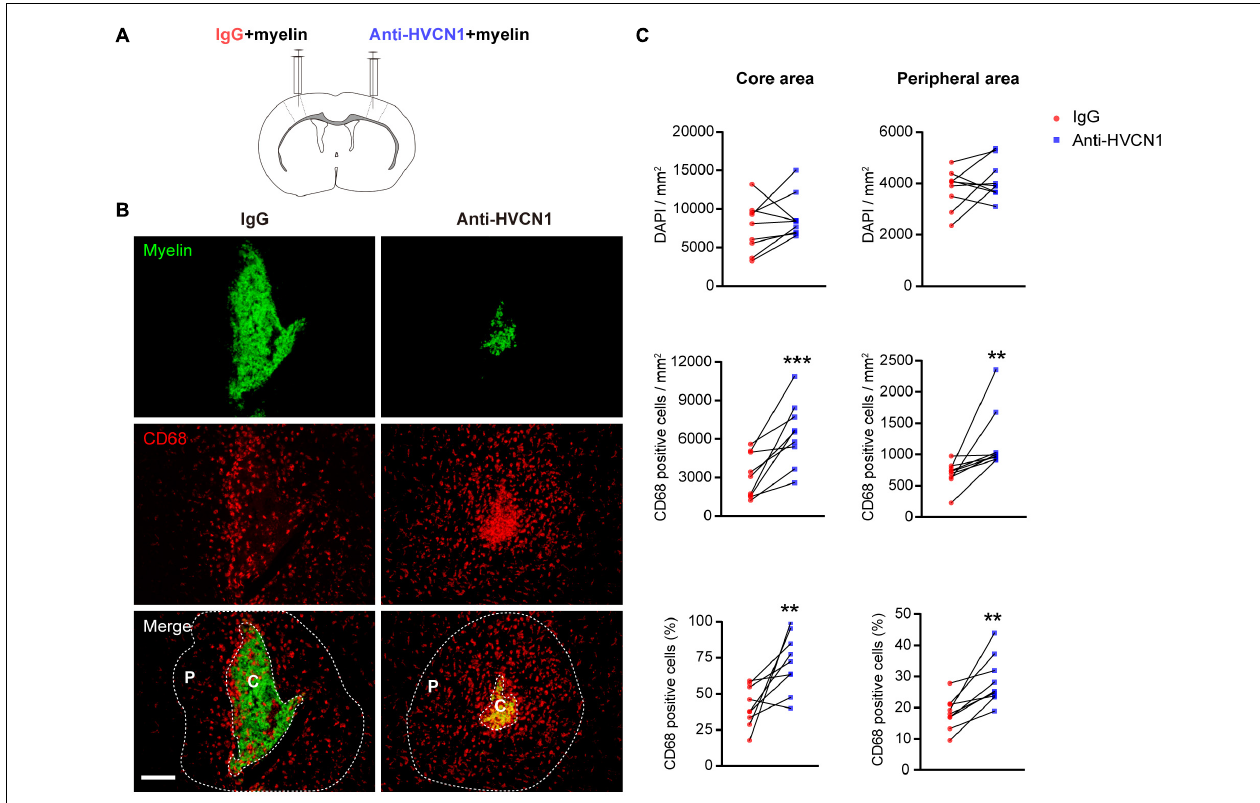
FIGURE 5 | Neutralization of HVCN1 with antibody promotes cell migration in vivo . (A) Schematic in vivo experiment design: CFSE-labeled myelin was co-injected with IgG on one side or with an HVCN1 antibody on the other side of the S1 cerebral cortex of the mouse. (B) Representative images show that neutralization with HVCN1 antibody increases CD68 + cell (red) density in both the core area (C) and the peripheral area (P) of the myelin (green) injection site. (C) Quantification of CD68 + microglia/macrophages density in the core area (left column) and the peripheral area (right column) of the myelin injection site ( n = 9). Scale bar (B) = 100 µ m. Data are presented as mean ± SEM. Statistical tests: paired two-tailed t -test (C) ; ** p < 0.01, *** p < 0.001.